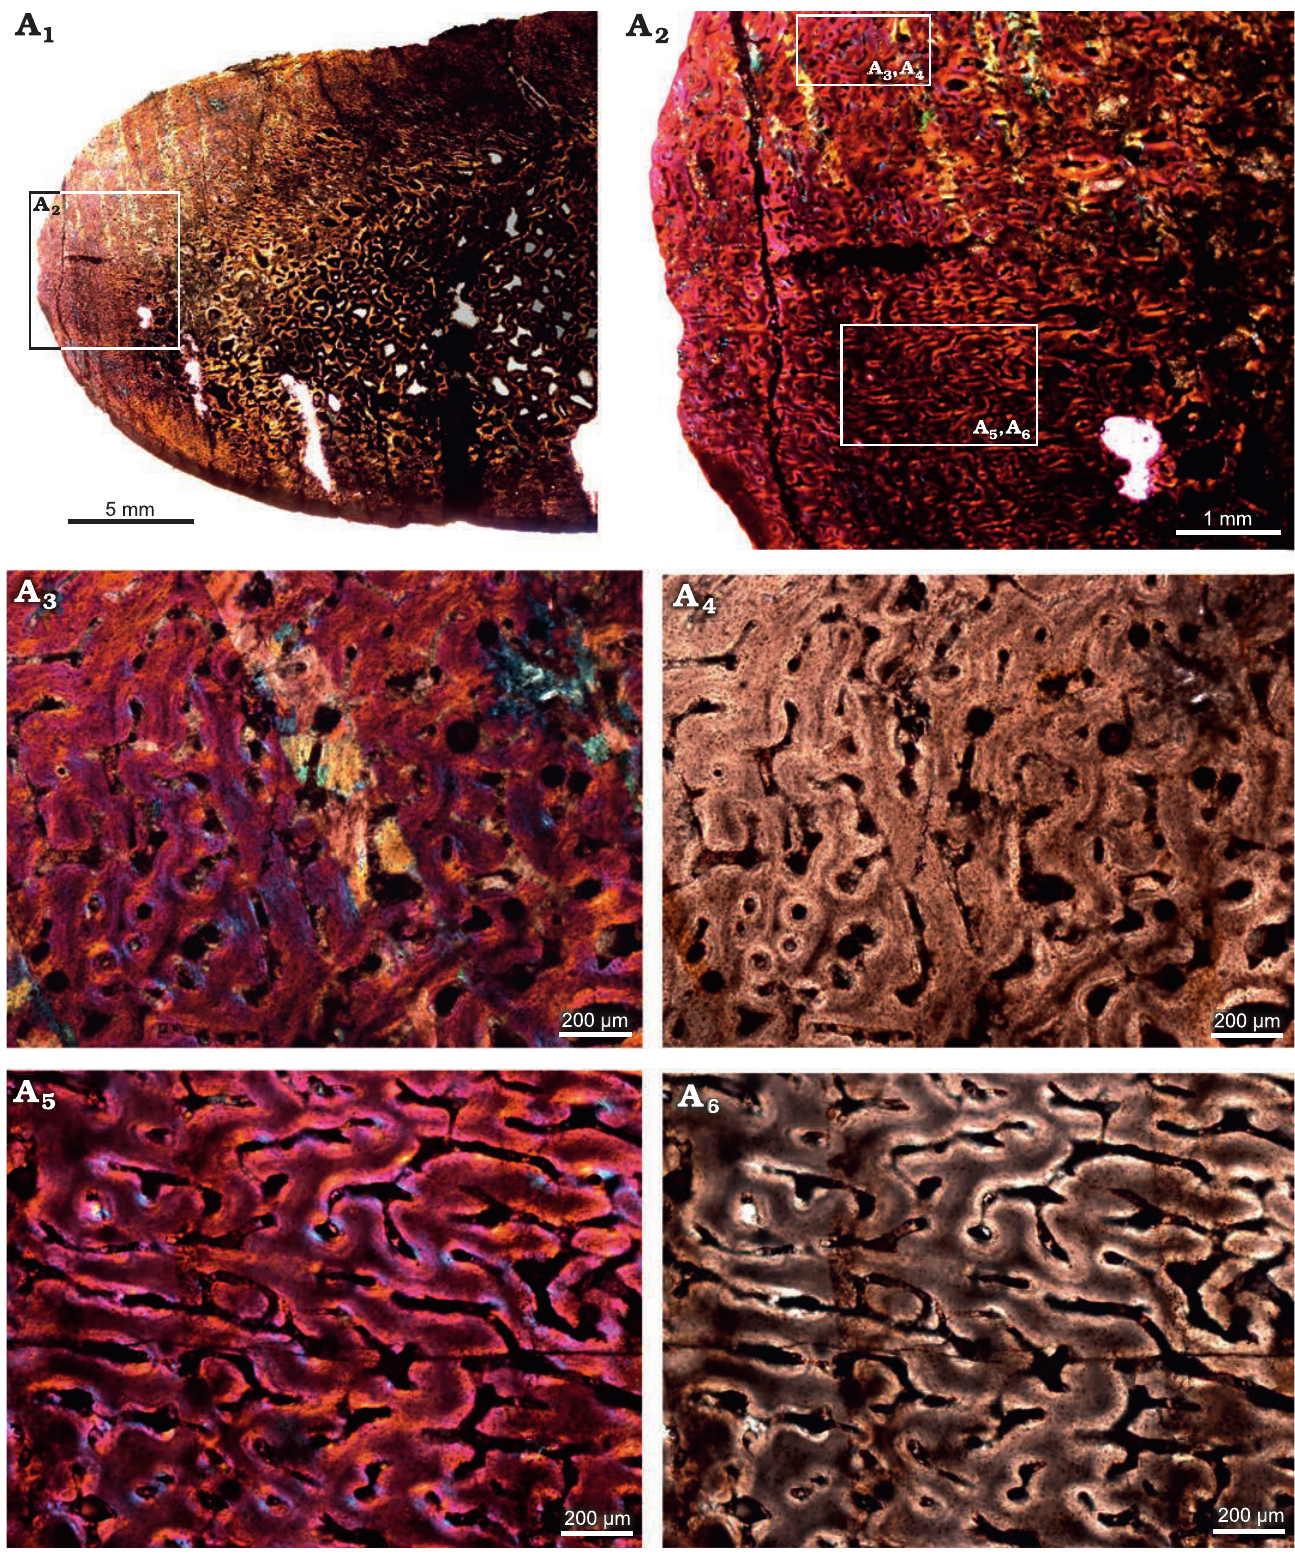
Fig. 3. Transverse sections of the tarsal (SAM-PK-12233c) of Jonkeria parva (Boonstra, 1955) from the middle Permian Tapinocephalus Assemblage Zone of the Karoo Basin of South Africa. A 1 , diaphyseal cross-section showing highly vascularized fibrolamellar bone tissue in the outer cortex and can- cellous bone tissue with extensively developed bony trabeculae in the medullary cavity; note: numerous enlarged resorption cavities in the perimedullary region. A 2 , detail showing highly vascularized reticular FLB. A 3 , A 4 , detail showing simple longitudinal vascular canals. A 5 , A 6 , detail showing reticular vascular canals. Photographs under cross-polarized light with lambda compensator (A 1 –A 3 , A 5 ) and ordinary light (A 4 , A 6